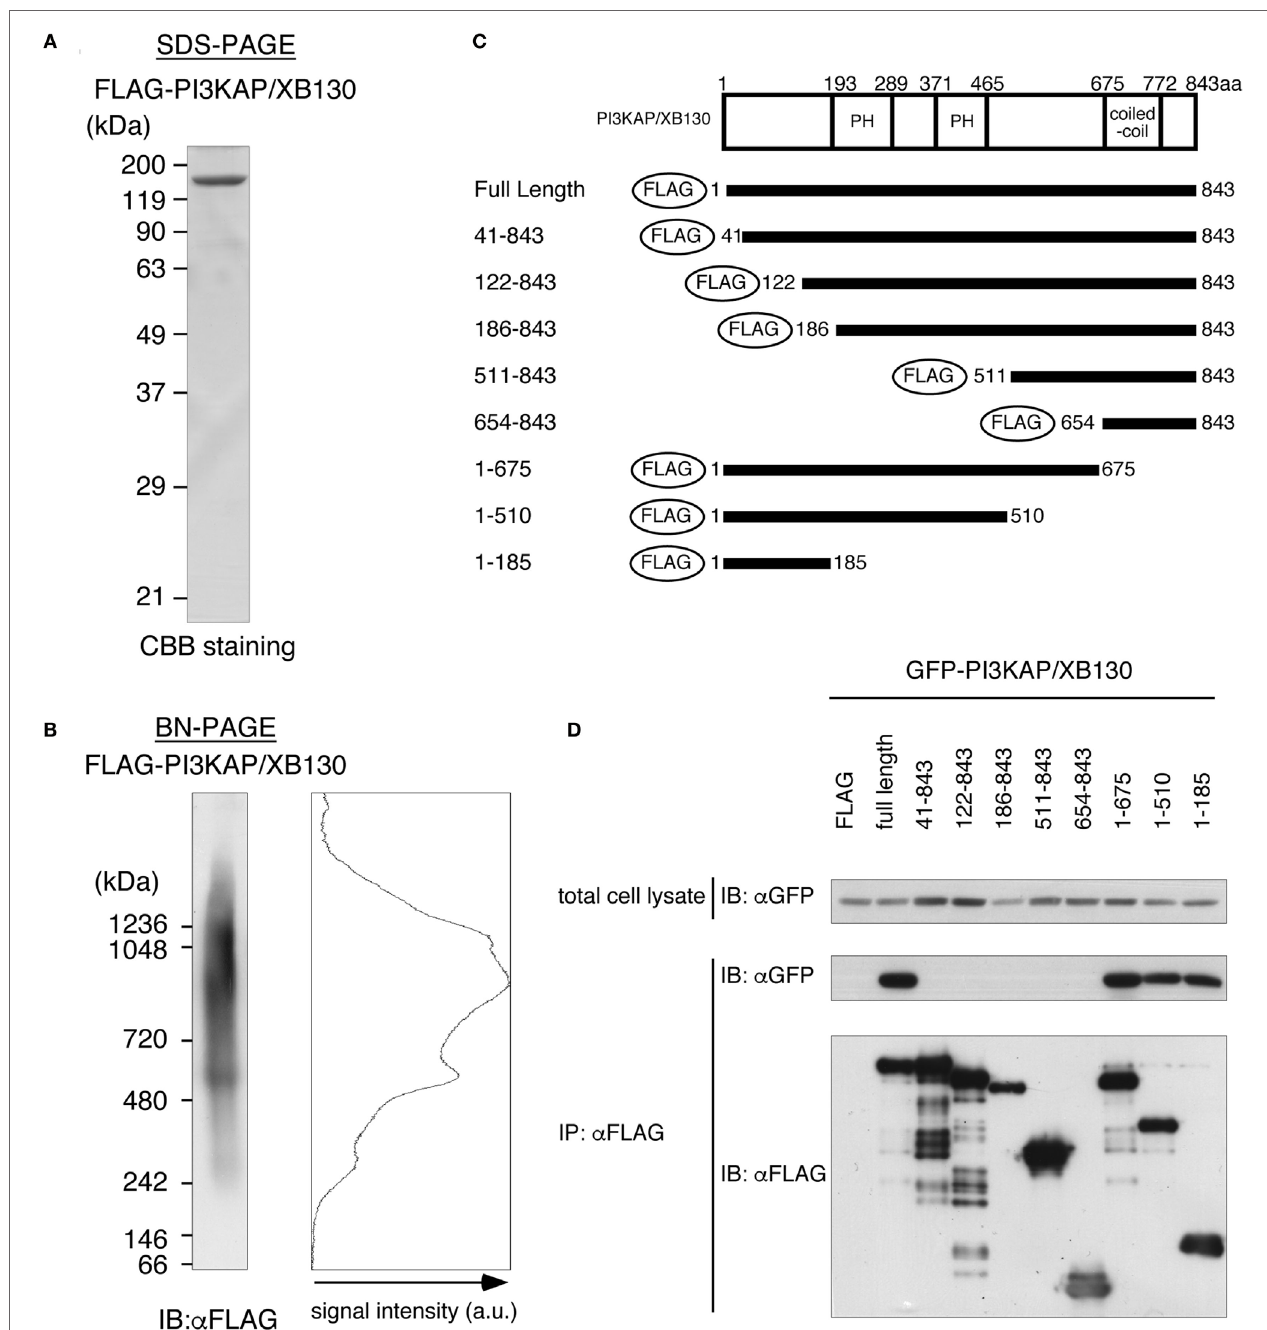
FigUre 4 | Pi3KaP/XB130 forms a multimer . (a,B) FLAG-tagged recombinant PI3KAP/XB130 was purified from HEK293T cells and then subjected to SDS-PAGE (a) or BN-PAGE (B) . (c) FLAG-tagged PI3KAP/XB130 deletion constructs used in the co-immunoprecipitation assays are shown. The numbers indicate the amino acid residues from the N-terminal end of PI3KAP/XB130. PH, PH domain; CC, coiled-coil domain. (D) GFP-PI3KAP/XB130 was co-transfected with full length or deletion mutant of FLAG-tagged PI3KAP/XB130 into HEK293T cells. The cell lysates were immunoprecipitated with anti-FLAG antibody, and then, the samples were subjected to immunoblotting with indicated